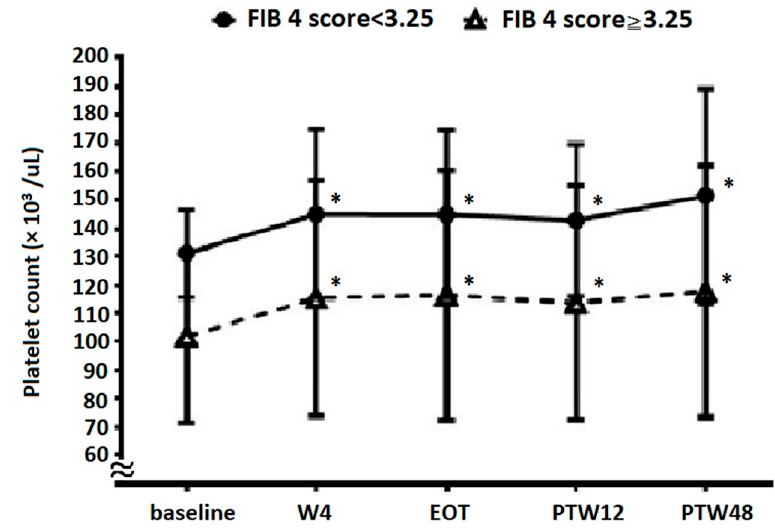
Figure 4. The evolution of platelet count in patients with and without advanced liver fibrosis. * Platelet counts are significantly increased compared with baseline levels ( p < 0.001 for W4 vs. baseline, EOT vs. baseline, PTW12 vs. baseline, and PTW48 vs. baseline). W4, week 4; EOT, end-of-treatment; PTW12, 12 weeks post-treatment follow-up; PTW48, 48 weeks post-treatment follow-up.